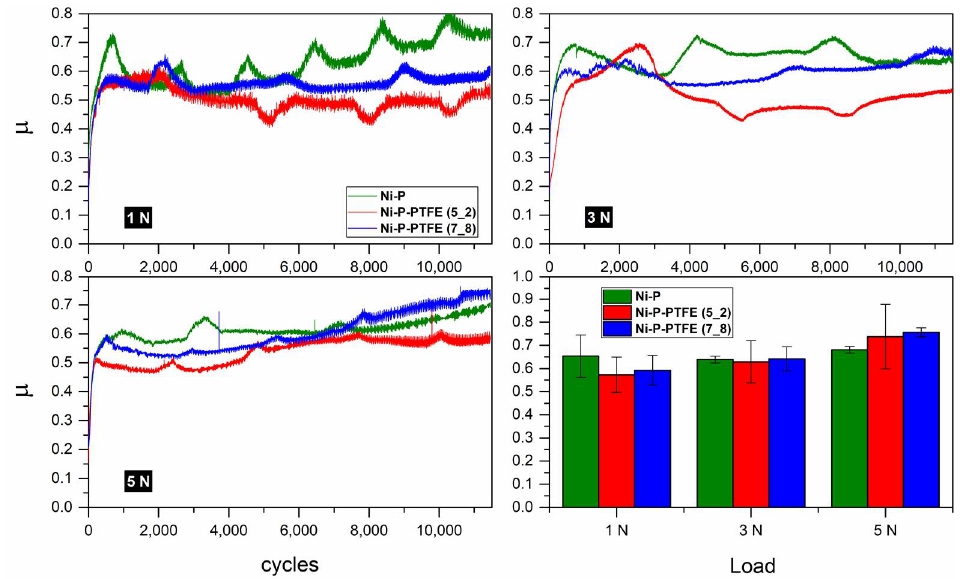
Figure 5. Tribological evolution of the Ni-P and Ni-P-PTFE coatings at 1, 3 and 5 N loads (0.6, 0.9 and 1.0 MPa) and average CoF measured for 3 samples for the last 1000 cycles of pin-on-disc tests carried out for 11,500 cycles.